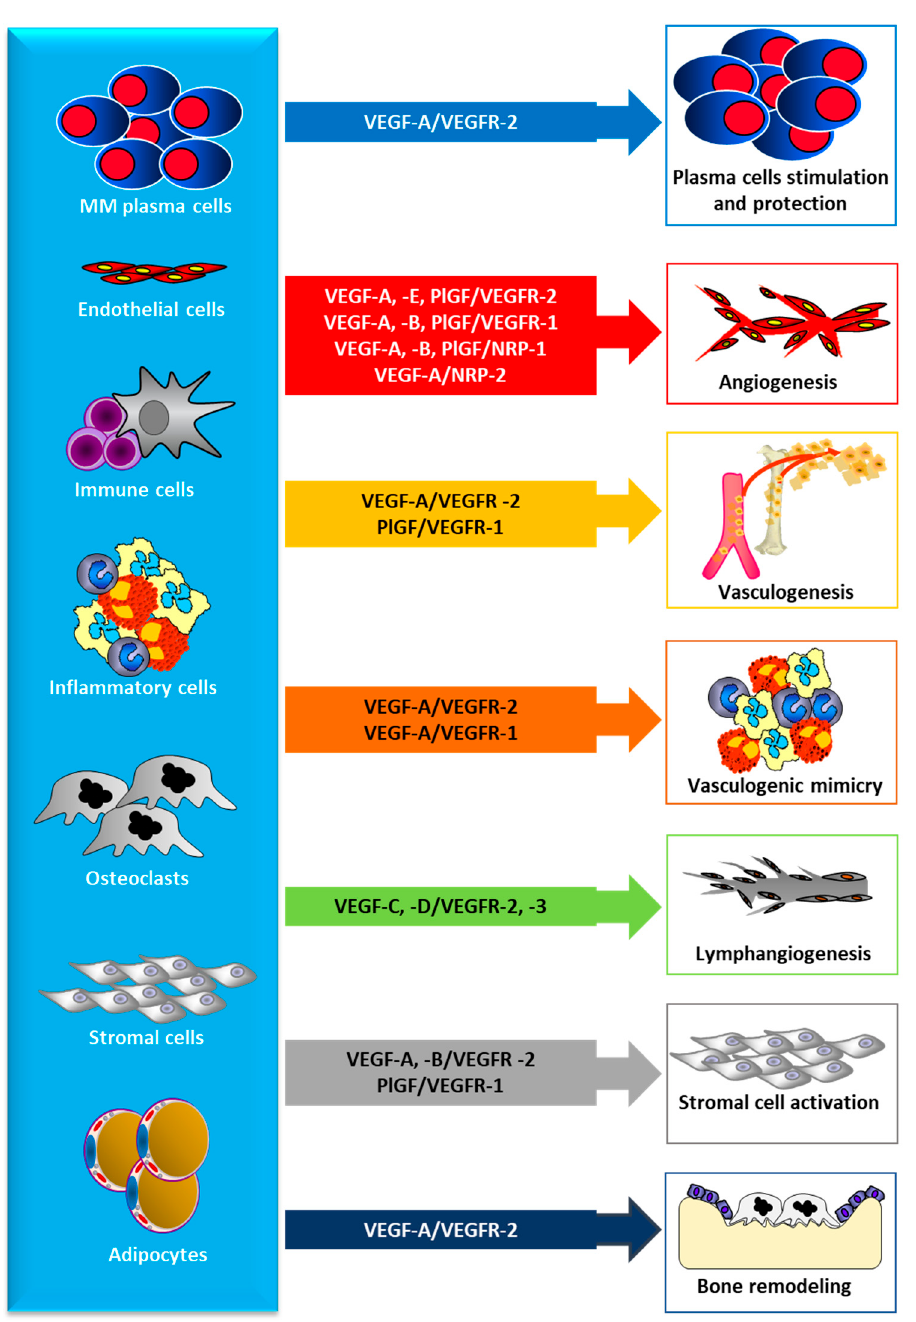
Figure 2. VEGFs and PlGF are is produced and released by all cells in the bone marrow microenvironment and displays several biological activities correlated to multiple myeloma (MM) progression. VEGF: vascular endothelial growth factor; VEGFR: VEGF receptor; PlGF: placental growth factor; NRP: neuropilin.